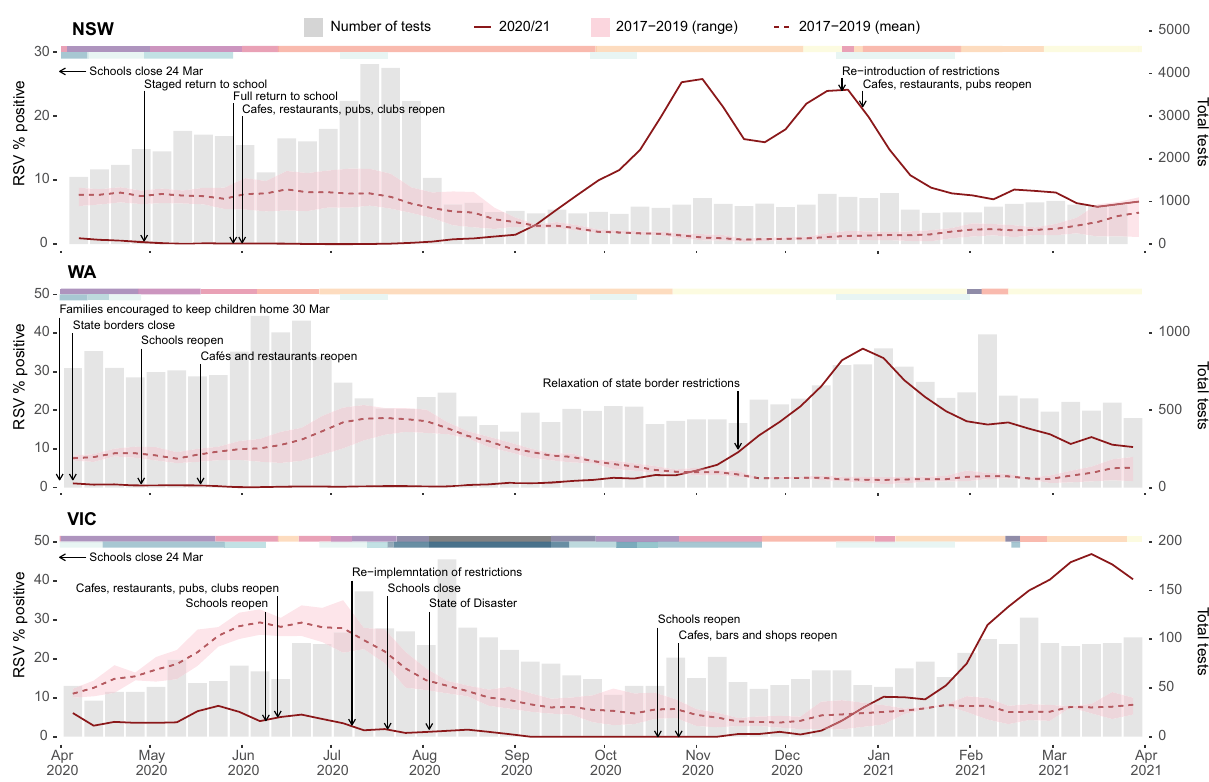
Fig. 1 The epidemiology of RSV detections in three Australian states — New South Wales (NSW), Western Australia (WA), and Victoria (VIC). Laboratory testing for RSV in 2020 as weekly percent positive (red line, left y -axis) and as total number of tests performed (grey bars, right y -axis). In each panel, the dashed red line represents mean monthly RSV percent positive over the three previous seasons, and corresponding red shading represents minimum and maximum weekly percent positive. Pink-shaded bars across the top of each plot indicate the severity of pandemic restrictions, with darker colours indicative of greater stringency. Blue bars across the top of each plot indicate the periods during which students did not attend school either due to pandemic restrictions or school holiday periods, with darker colours indicative of more stringent school